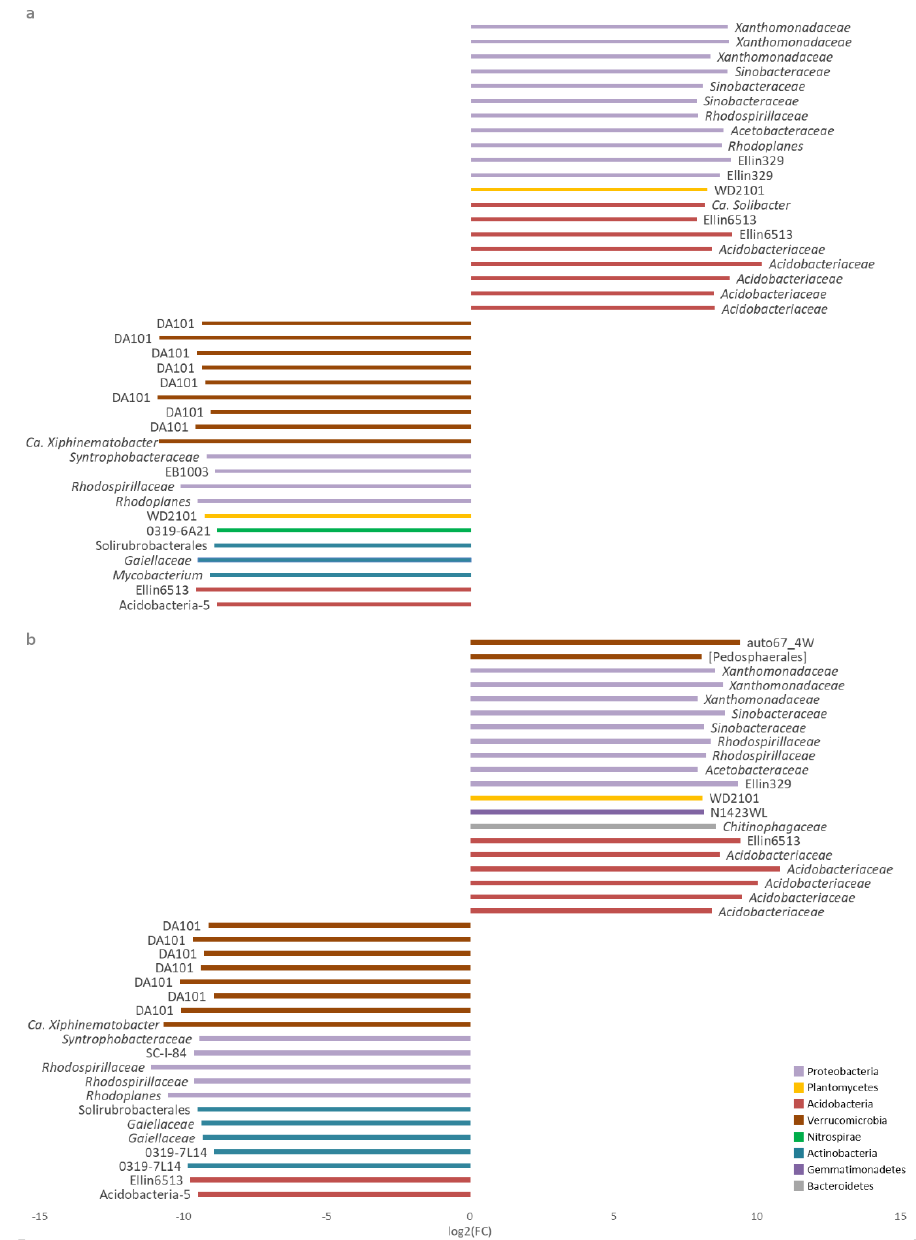
Figure 5. Differentially abundant OTUs between Eastnor–Richmond ( a ) and Hathclands–Richmond ( b ). The top 20 (the highest log2 fold changes) significantly enriched OTUs determined by DESeq 2.0 are depicted (FDR-corrected p < 0.05). Negative log2 (FC): Eastnor ( a ) and Hatchlands ( b ); Positive log2 (FC): Richmond ( a and b ).